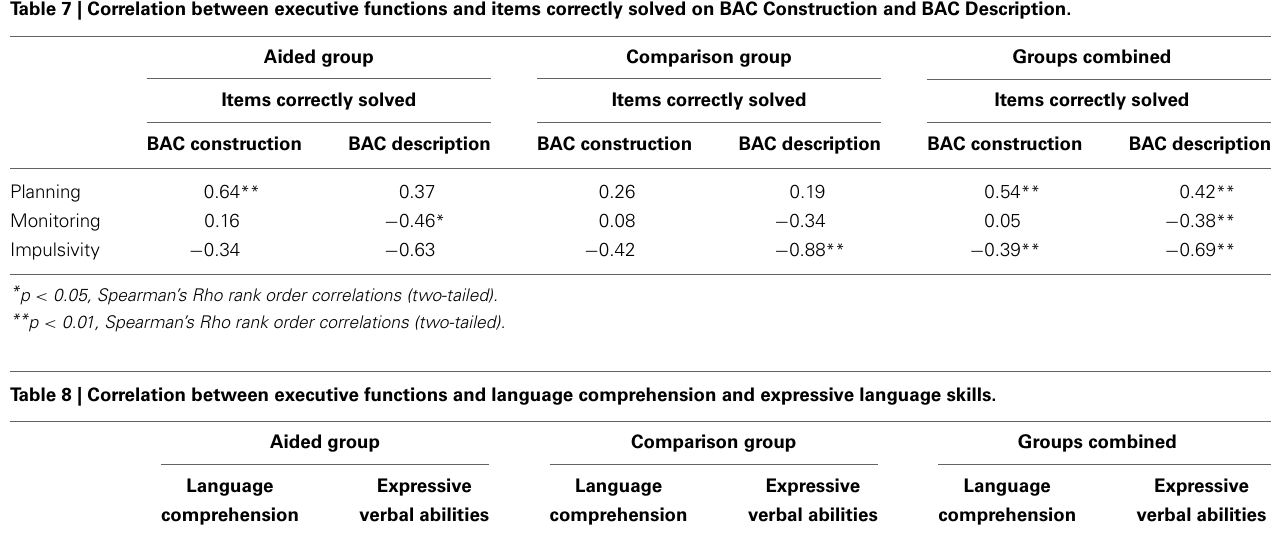
Table 7 | Correlation between executive functions and items correctly solved on BAC Construction and BAC Description.